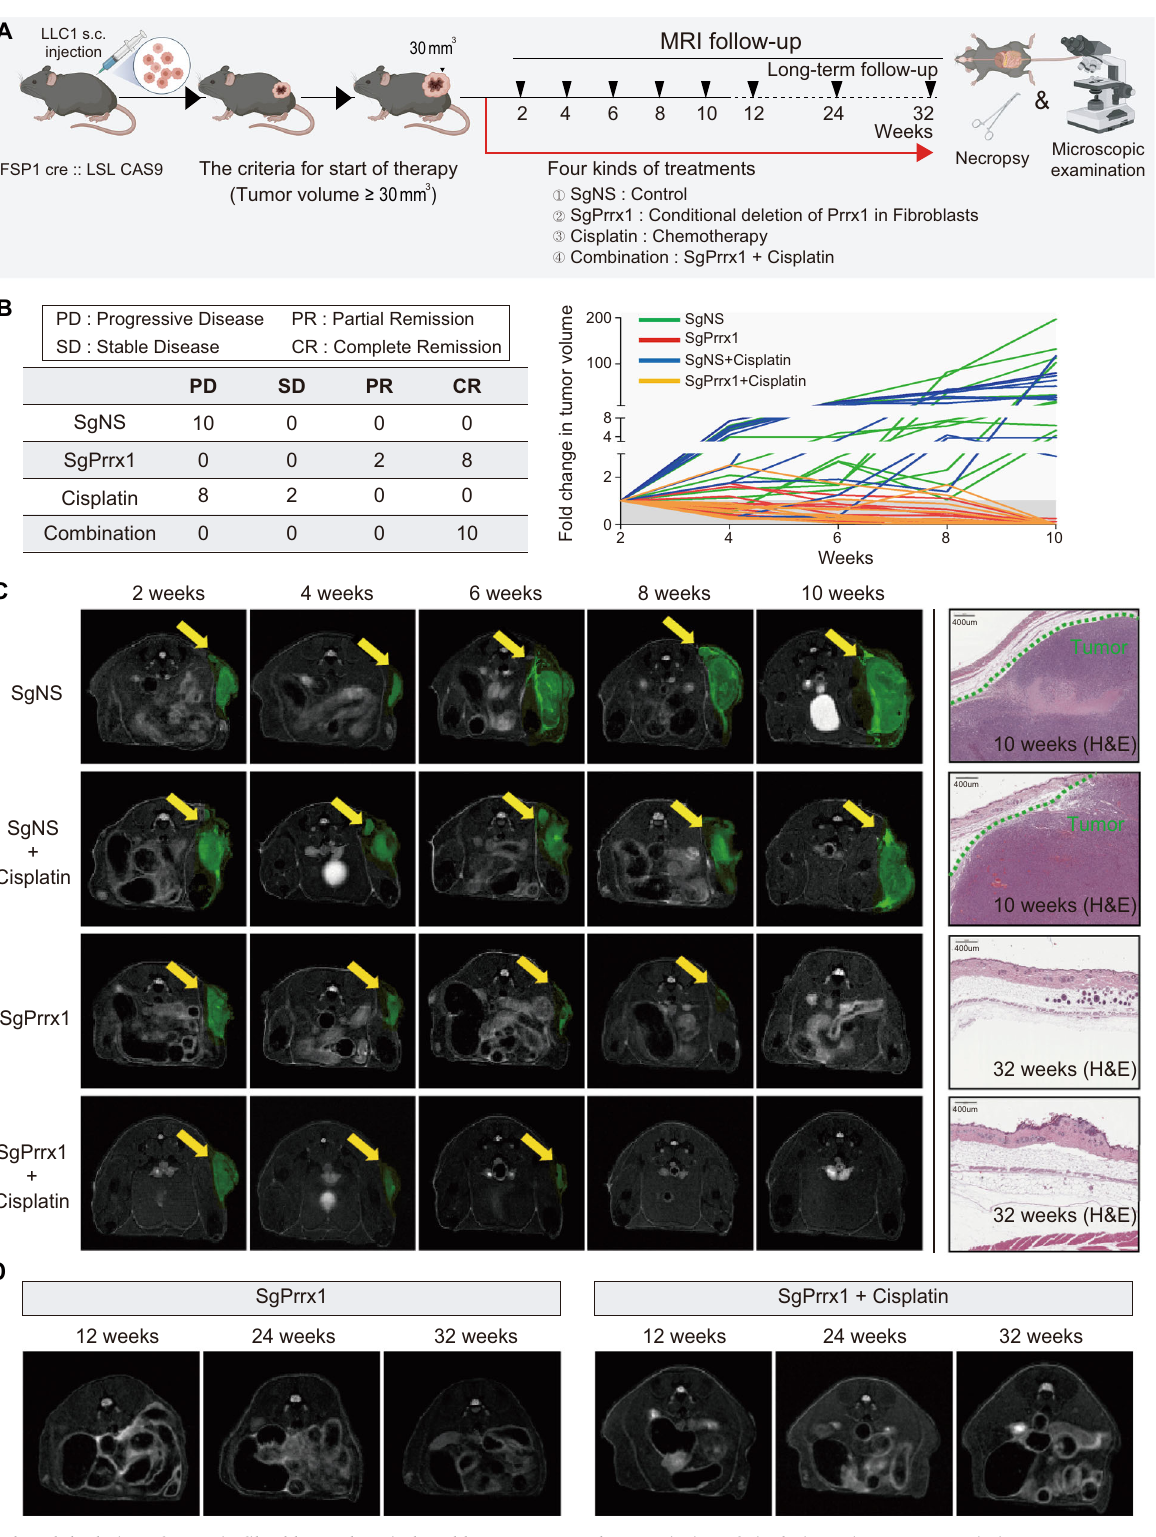
Fig. 9 Induced depletion of Prrx1 in fi broblasts alone induced long-term complete remission of cisplatin-resistant cancers in immunocompetent mice. A LLC1-Luc-GFP cancer cells were transplanted subcutaneously into transgenic mice (FSP1; cre CAS9 EGFP ). Four kinds of treatments were administered ( n = 10 for each of four groups; sgNS, sgPrrx1, cisplatin, and sgPrrx1 + cisplatin) after tumor formation (tumor size > 30 mm 3 ). B Comparison of tumor response in each treatment. Tumor growth curves; n = 10 mice/group. C Tumor volume was monitored using MRI for 10 weeks. Representative images of tumor growth monitored using MRI. The yellow arrows indicate tumor (green). Representative H&E images of primary tumor site in each group. D Additional MRI follow-up was performed to con fi rm long-term complete remission of tumors in the two groups (sgPrrx1 and sgPrrx1 + cisplatin). Source data are provided as a Source Data fi